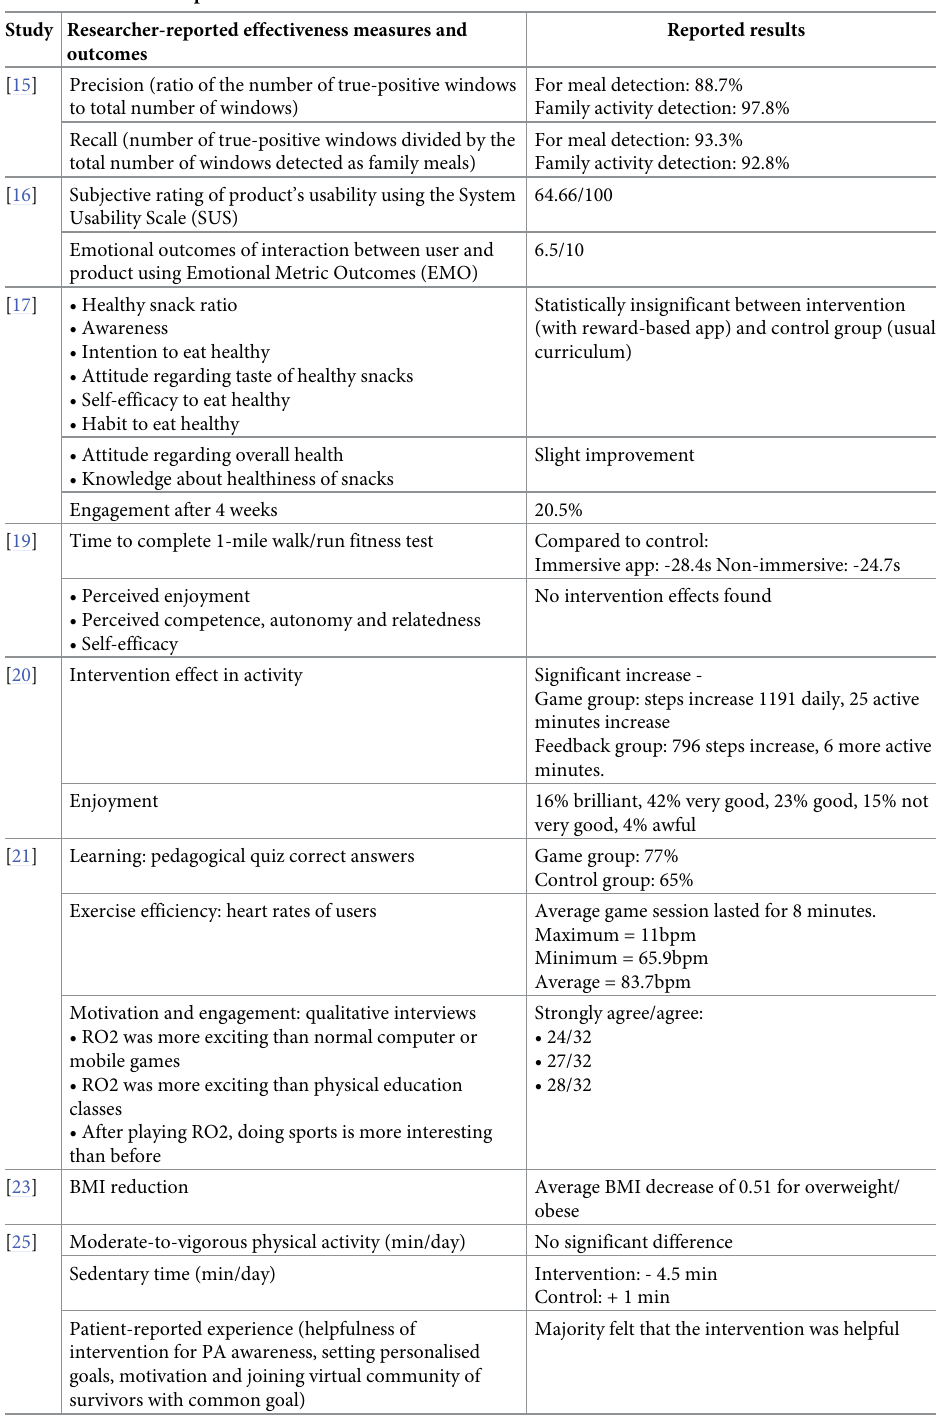
Table 4. Researcher-reported outcomes. Study Researcher-reported effectiveness measures and